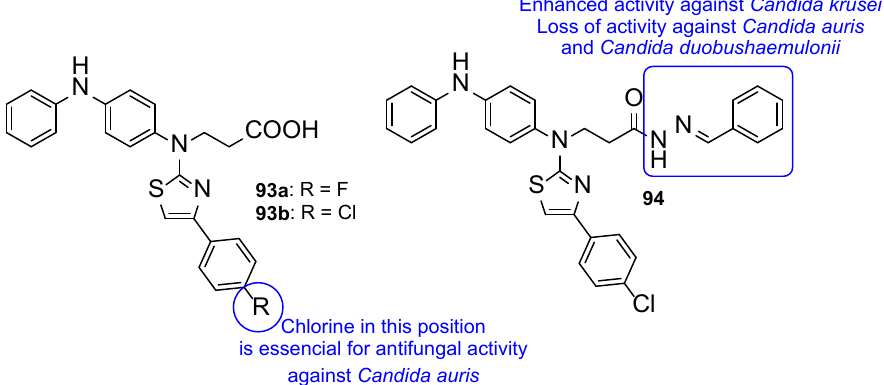
Figure 45. Chemical structure of compounds 93a – b and 94 , as well as SAR for the Candida species [125].